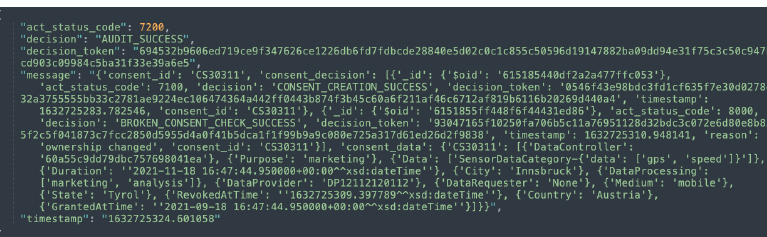
Figure 11. Sample response to a request for partial auditing based on consent.